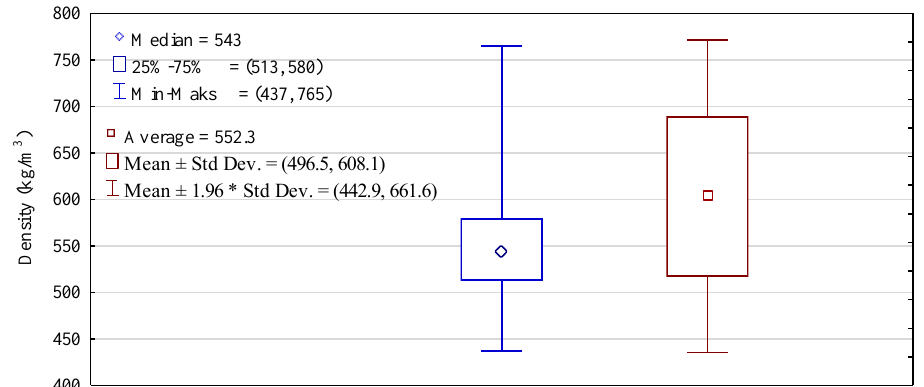
Figure 5. A box plot for statistical data concerning density of tested timber.